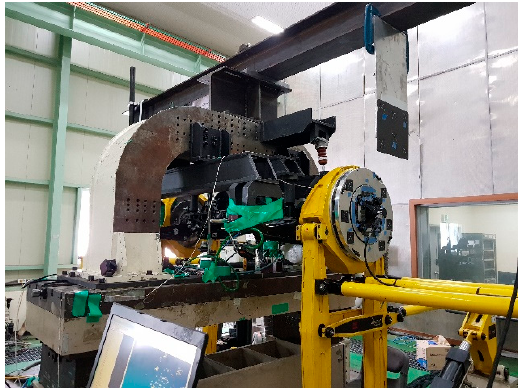
Figure 1. Suspension module under preliminary tests.